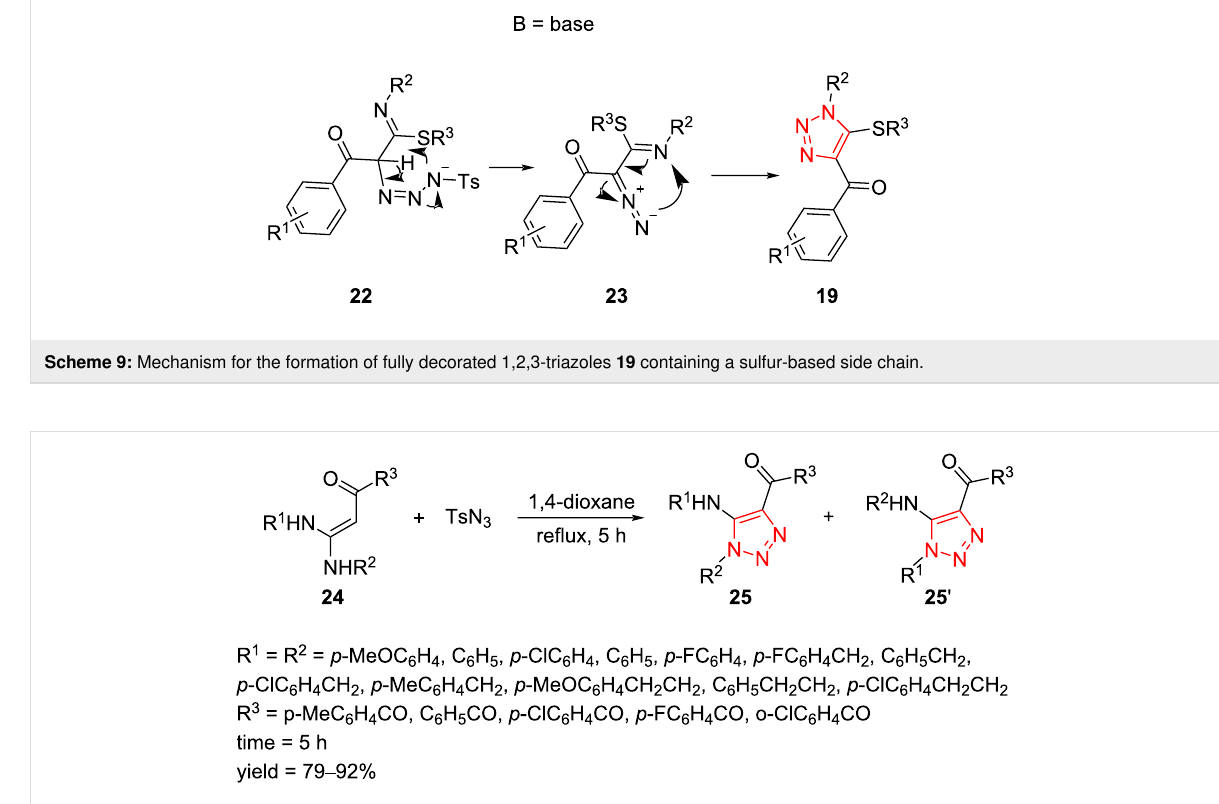
Scheme 10: Synthesis of fully decorated 1,2,3-triazole compounds 25 through the regioselective addition and cyclization reaction of EDAMs 24 with p -methylbenzenesulfonyl